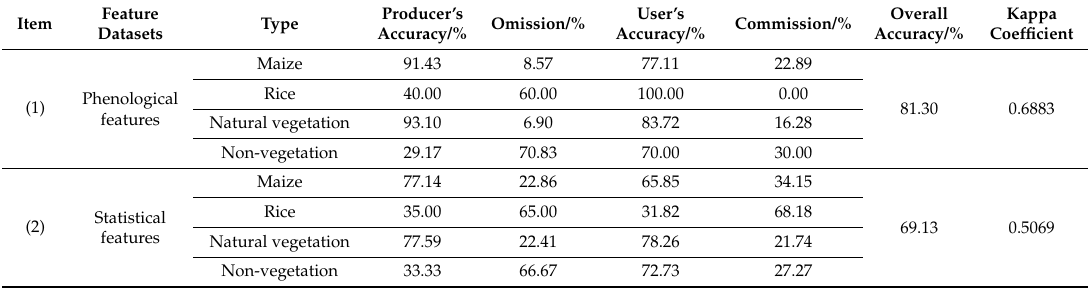
Table 4. Identification accuracy of maize based on different feature